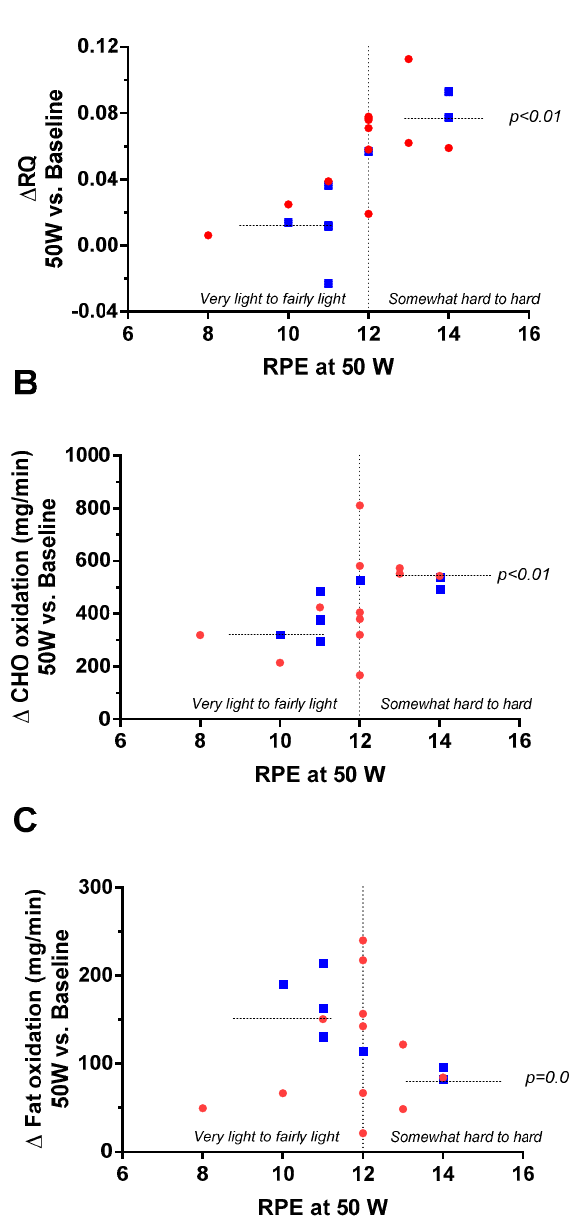
Figure 5. Plots of changes in respiratory quotient ( A ; ∆ RQ), carbohydrate ( B ; ∆ CHO) oxidation, and fat ( C ; ∆ fat) oxidation at 50 W relative to baseline (RB) as a function of the rate of perceived exertion (RPE) at 50 W in men (in blue) and women (in red).